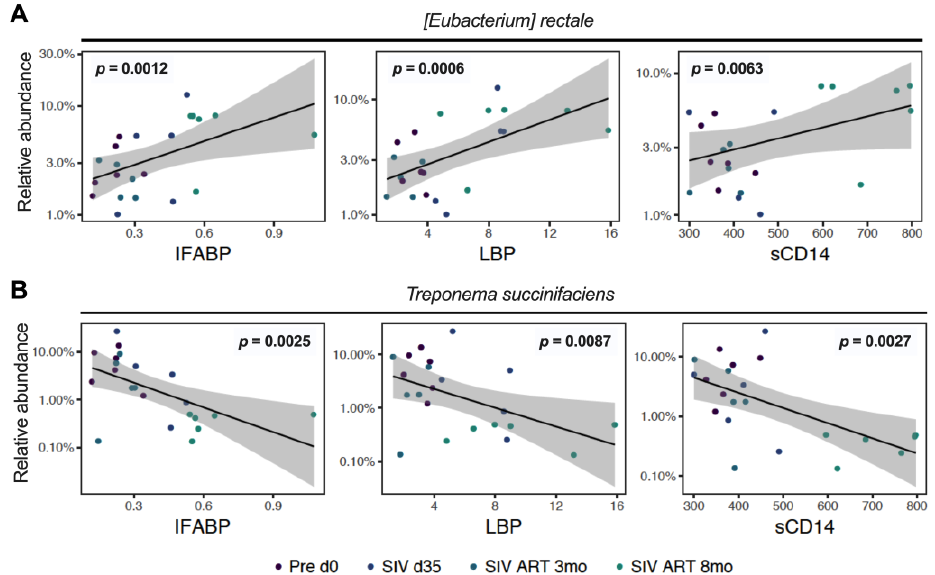
Figure 7. Correlations of gut bacteria with leaky gut biomarkers. Bacterial abundance levels were correlated with plasma levels of an IEBD marker, IFABP, and surrogate markers of MT including LBP and sCD14 using linear mixed effects models to examine the interrelationship between gut microbes and epithelial barrier function. ( A ) Species showing significant positive correlation with IFABP, LBP, and sCD14; and ( B ) species showing significant inverse correlation with IFABP, LBP, and sCD14 through the course of